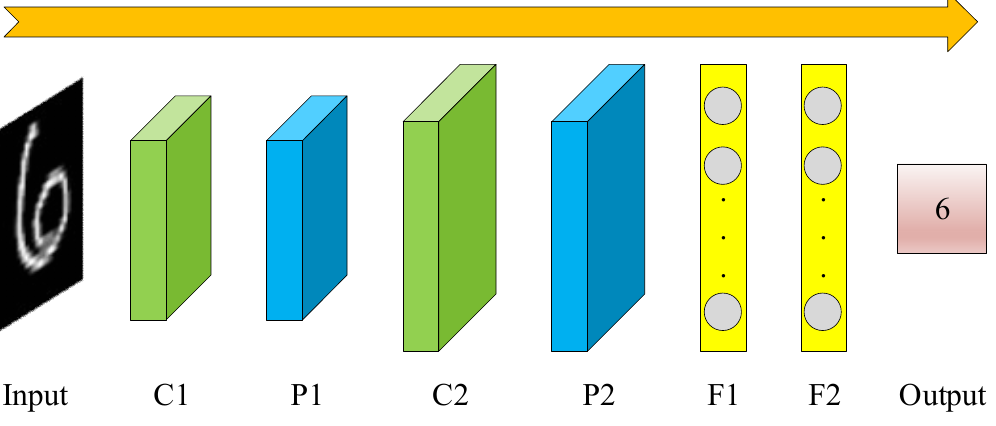
Figure 2. LetNet-5 neural network model.